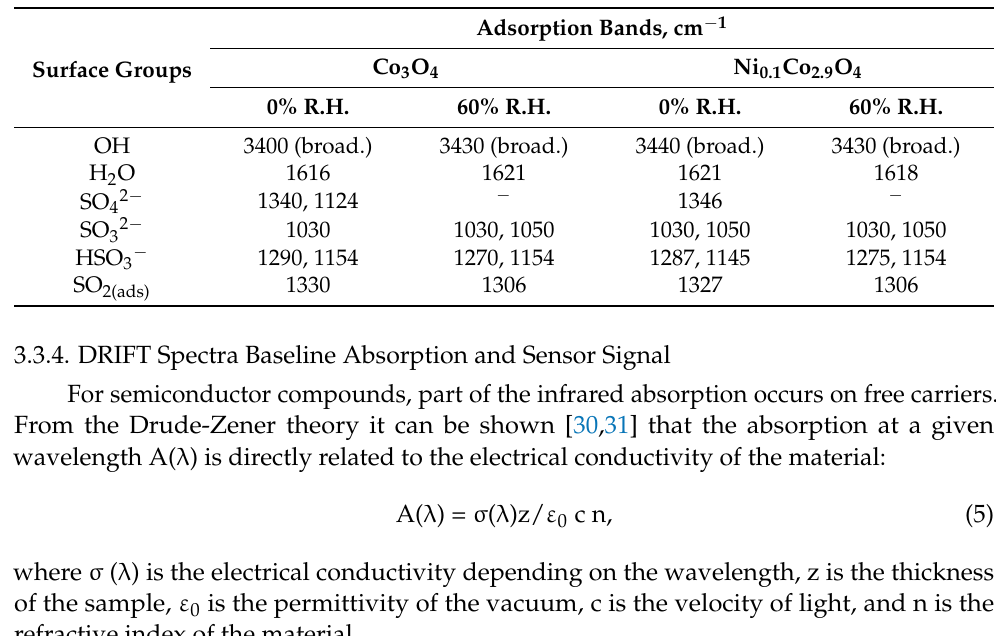
Table 3. Absorption bands on Co 3 O 4 and Ni 0.1 Co 2.9 O 4 DRIFT spectra.